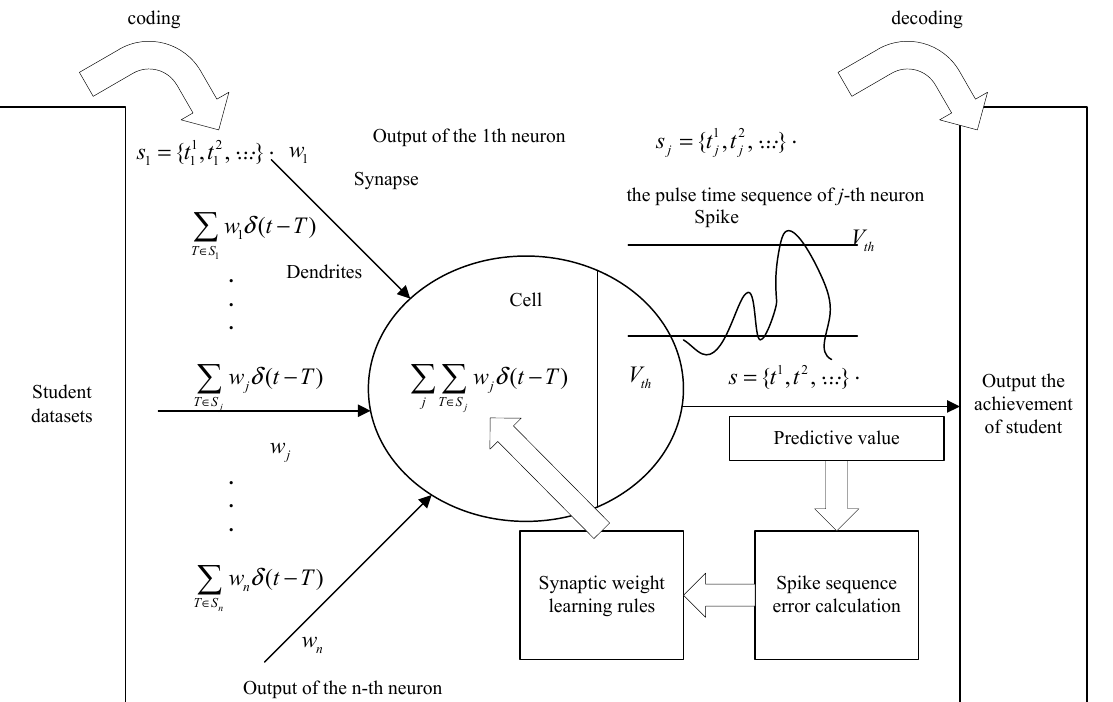
Figure 2. Architecture of Student Achievement Prediction